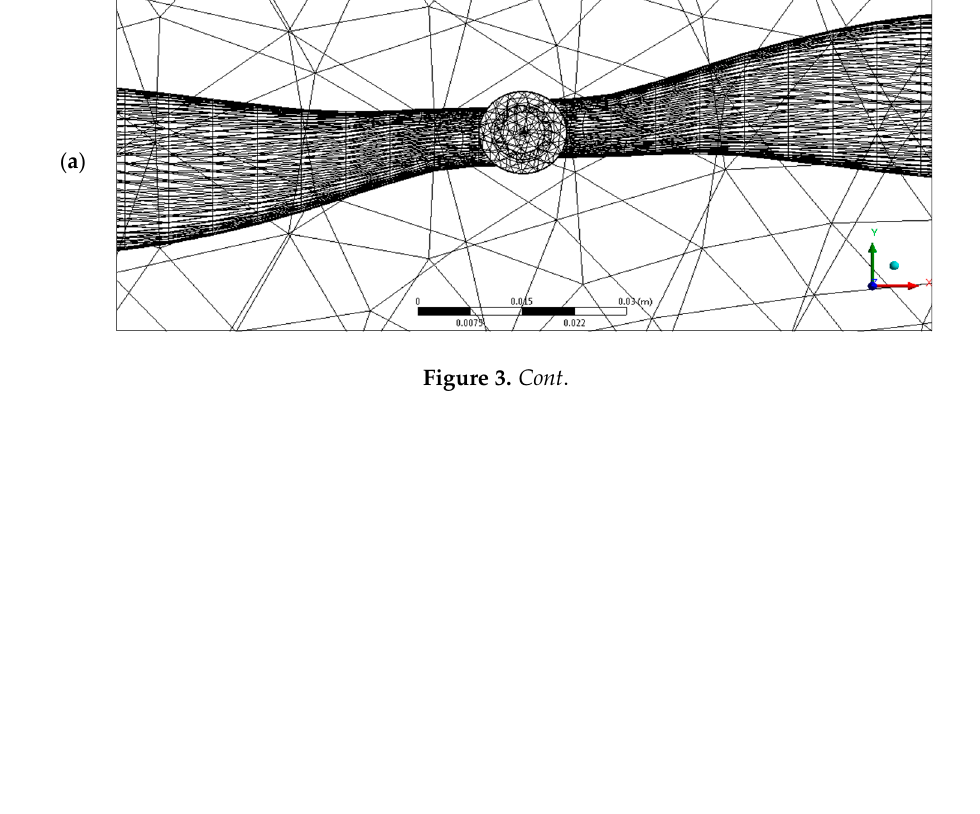
Table 2. Details of the meshing grid.